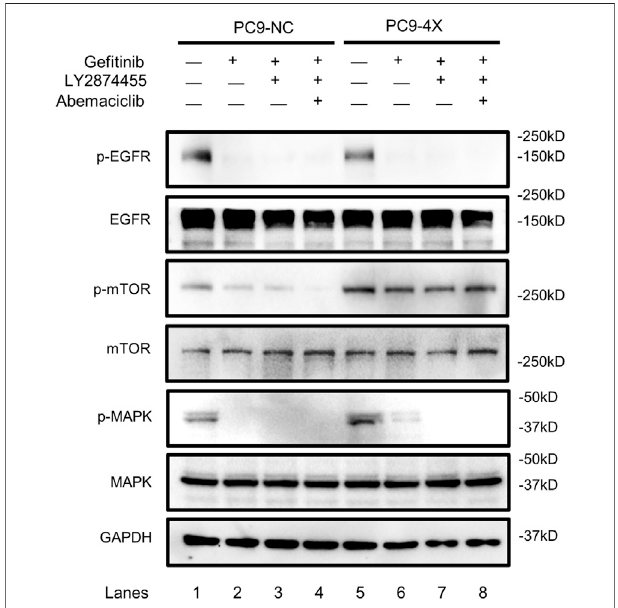
FIGURE 4 | The activity of the EGFR, mTOR, and MAPK in response to ge fi tinib (10 nM) and/or combined treatment with LY287445 (10 nM) and/or abemaciclib(10 nM)inPC-9-NCandPC-9-4Xcells.Thecellsweretreatedfor 24 h before the Western blot analysis. GAPDH was used as a loading